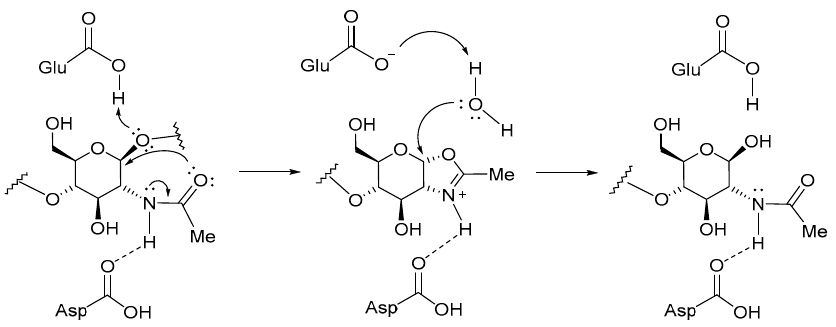
Figure 4. Hydrolysis mechanism for GH 18 chitinases.